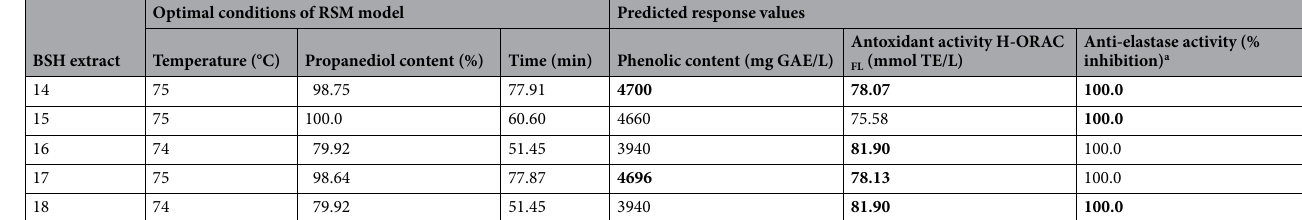
Table 3. Optimization procedure using RSM to maximize phenolic content and/or antioxidant activity and/ or anti-elastase activity. Bold values shows optimized variable(s) for each extract. a The effective or inhibitory concentration that reduces the enzyme activity to 50% (EC 50 value) of the control EGCG is 2.3 mg/L (experimental data, n =